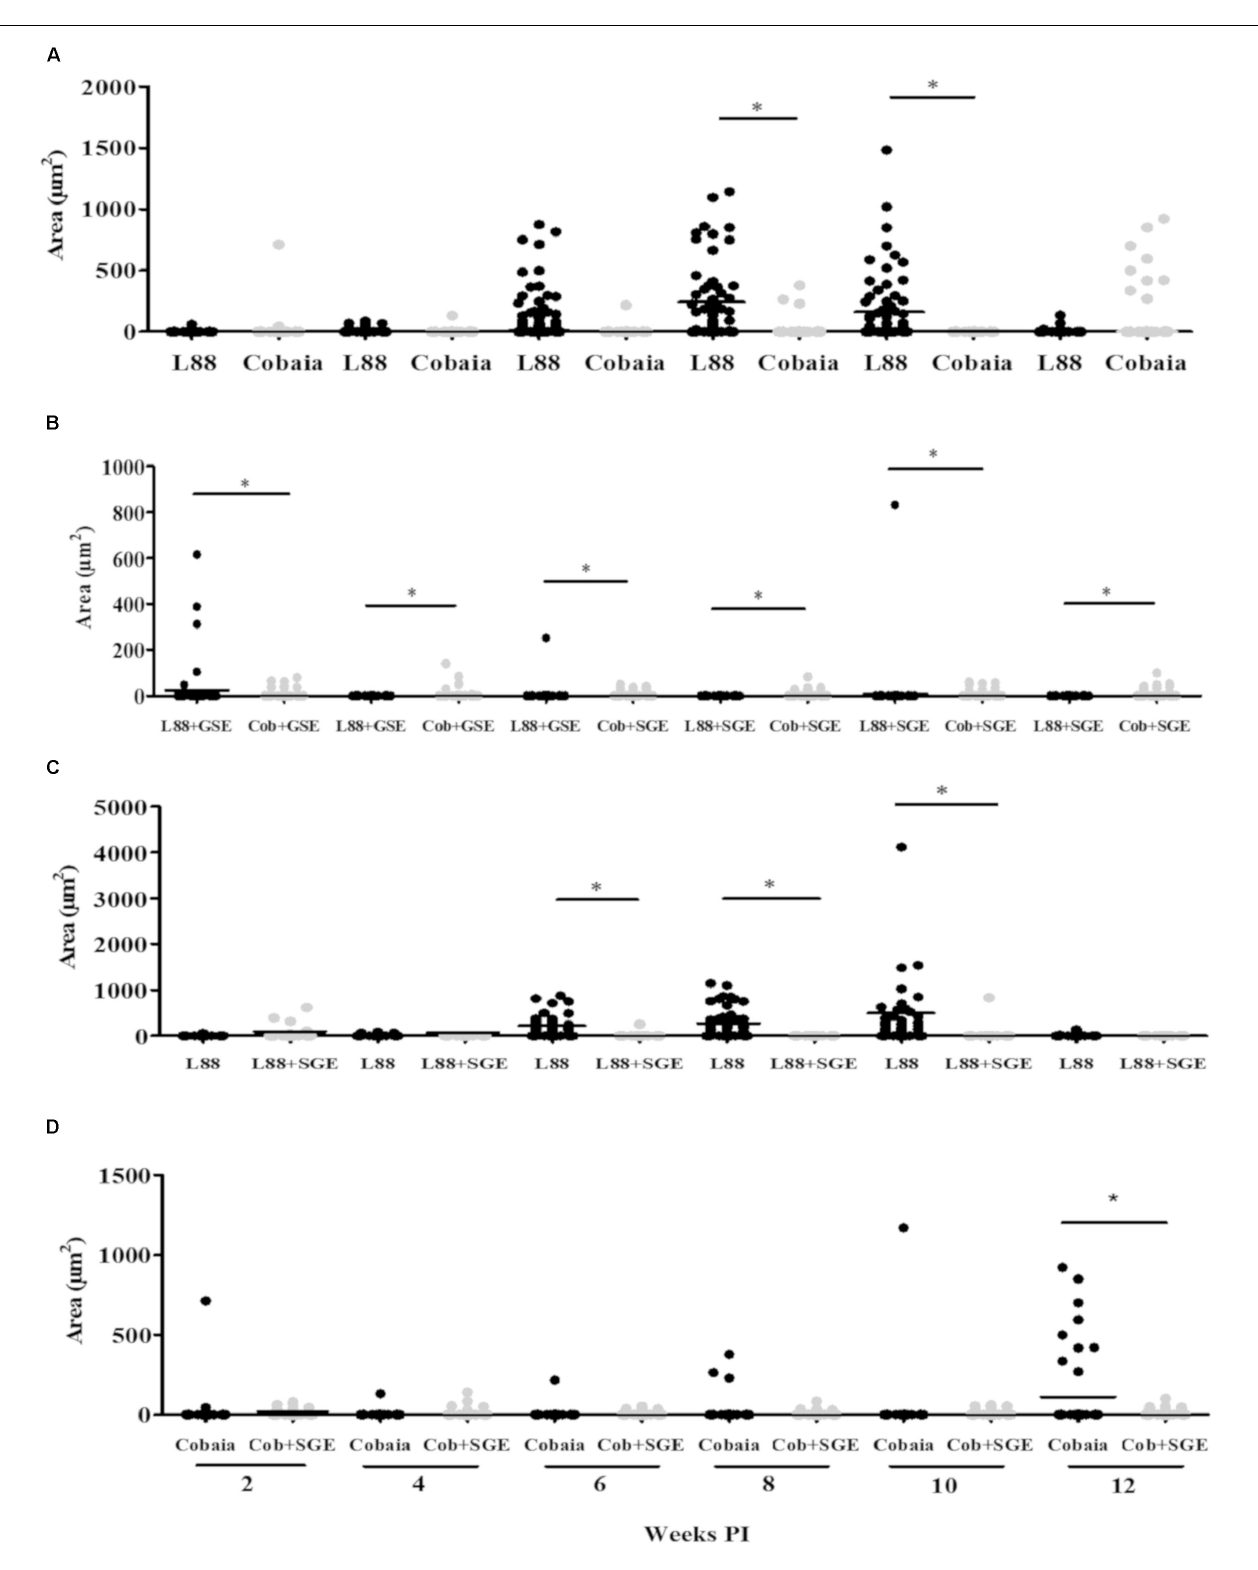
FIGURE 7 | Morphometric analysis ( µ m 2 ) of the immunohistochemistry (IHC) of C. porcellus infected with L. enriettii (L88 and Cobaia) strains in the absence/presence of salivary gland extract (SGE). Areas of L1 positive cells staining in L88 versus Cobaia strains in the absence (A) or presence (B) of SGE. L88 (C) and Cobaia (D) strains in the absence/presence of SGE at 2, 4, 6, 8, 10 and 12 weeks PI. Asterisks indicate statistical significance between groups at p < 0.05.